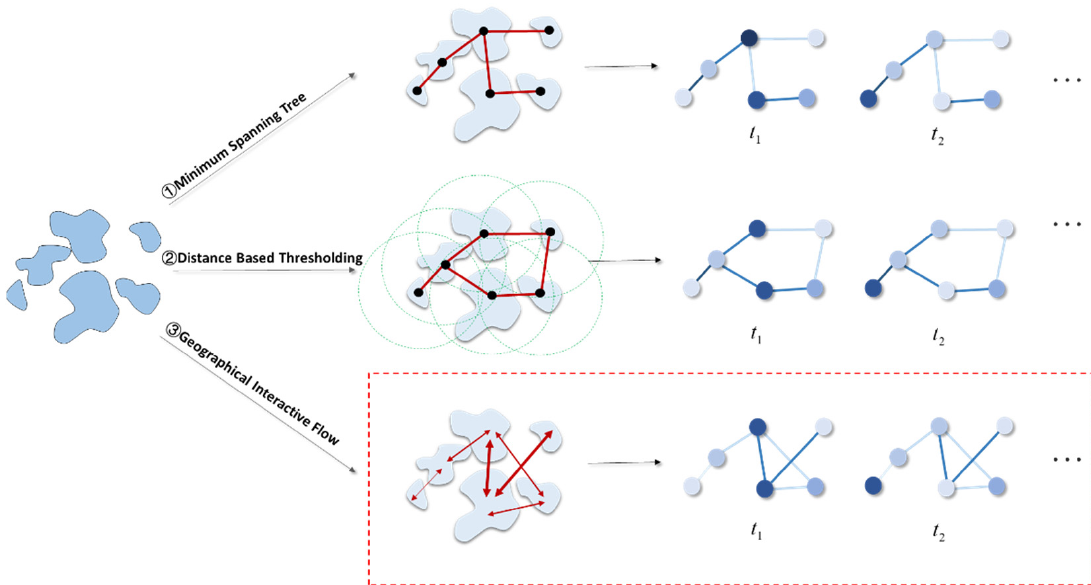
Figure 2. Graph construction methods considered in this study were minimum spanning tree (MST), distance-based thresholding (DBT), and geographical interactions (GIF). MST keeps all nodes connected while minimizing the number of connected edges. DBT connects nodes according to distance; the connected edges are different with the size of the distance threshold. GIF, which uses the geographical interaction flows of historical user movement records, is the method used in this study.